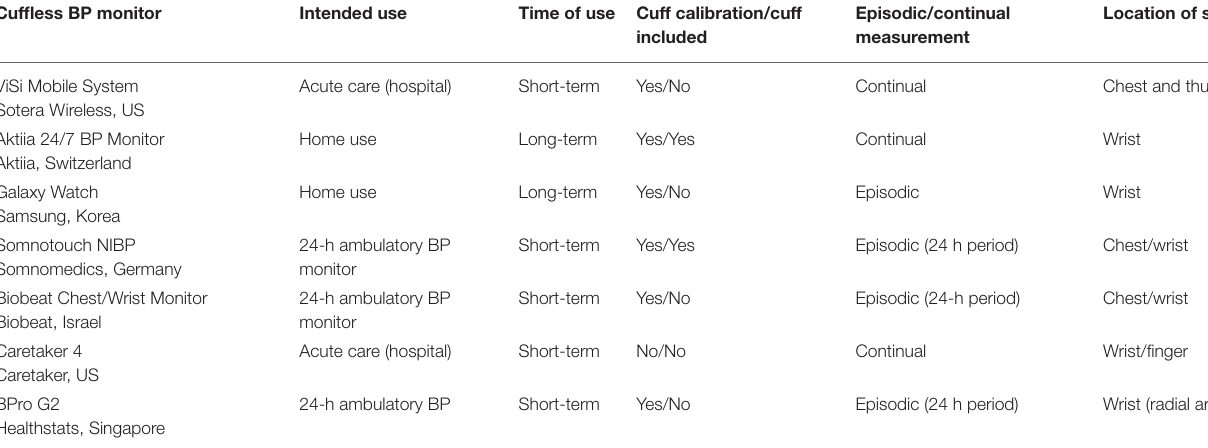
TABLE 2 | List of current commercially available cuffless BP monitoring